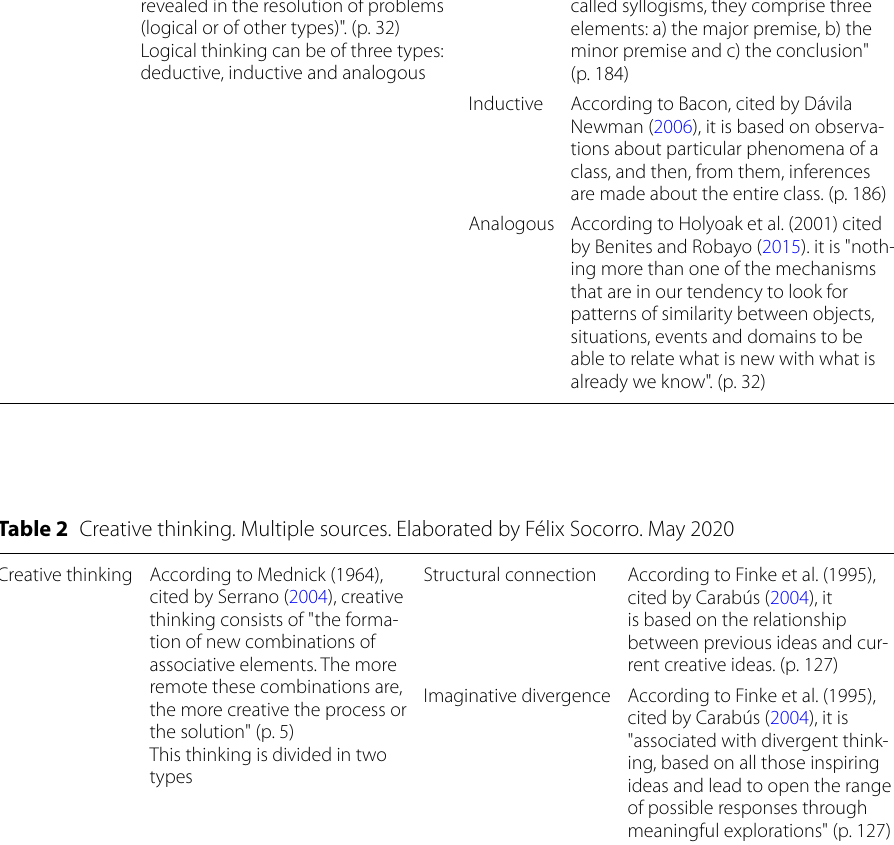
Table 1 Logical thinking: main features. Multiple sources. Elaborated by Félix Socorro. May 2020 Logical thinking For Cohen (1977), cited by Menén- dez (2009), "the logical processes of